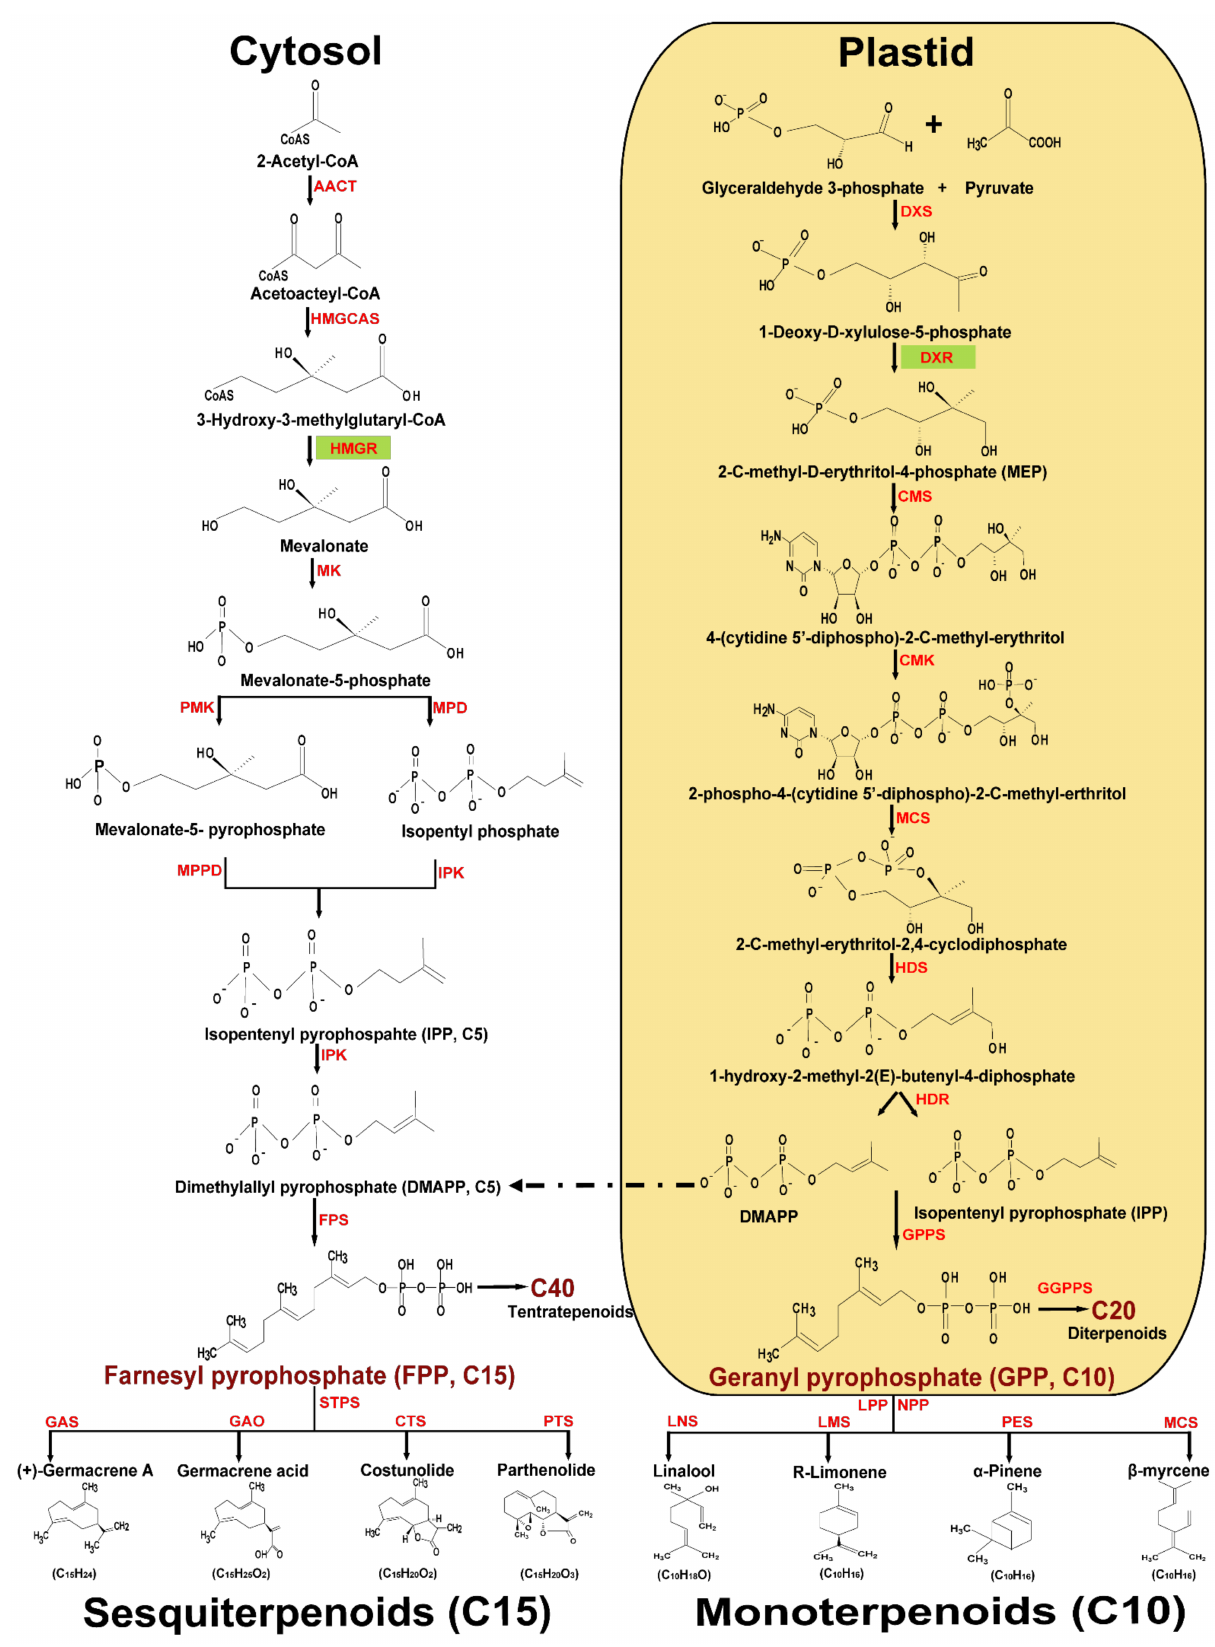
Figure 1. Terpenoid biosynthesis in plants. There are two distinct pathways in plants for the synthesis of the universal precursors isopentenyl pyrophosphate (IPP) and dimethyl-allyl pyrophosphate (DMAPP): the